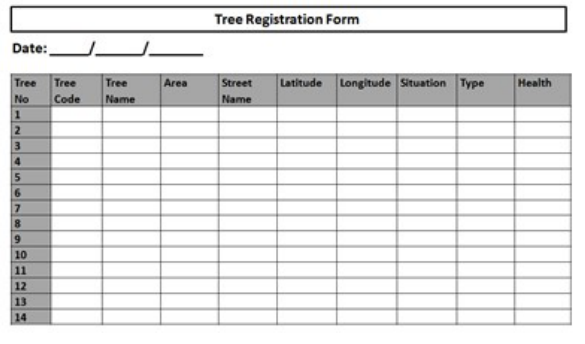
Figure 2. Tree Registration